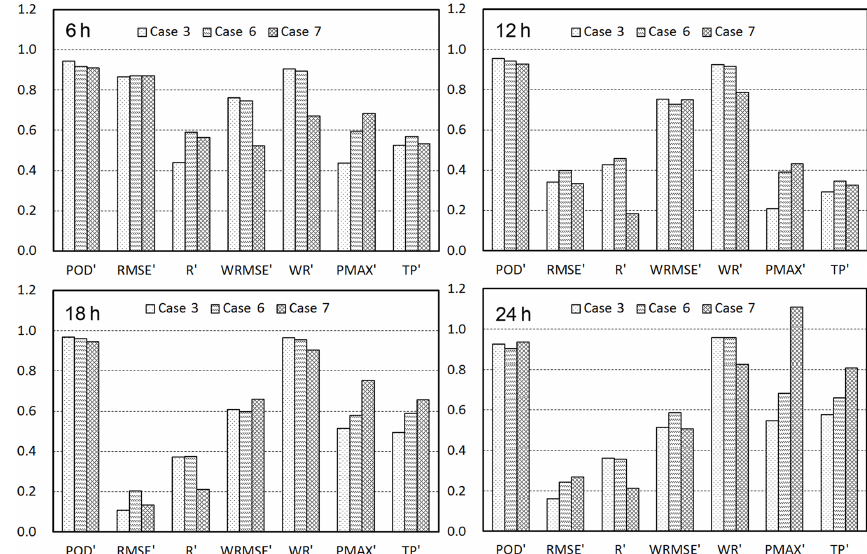
Figure 6. As in Fig. 3, but for the experiments in scenario three with different horizontal resolutions. Case 3 has an initial downscaling ratio of 1:3:3 with horizontal grid spacing of 40.5, 13.5, and 4.5km, whereas cases 6 and 7 have the same large horizontal grid spacing with nesting ratios of 1:5:5 and 1:7:7, respectively. The innermost grid spacing is 1.62km in Case 6 and 0.826km in Case 7.